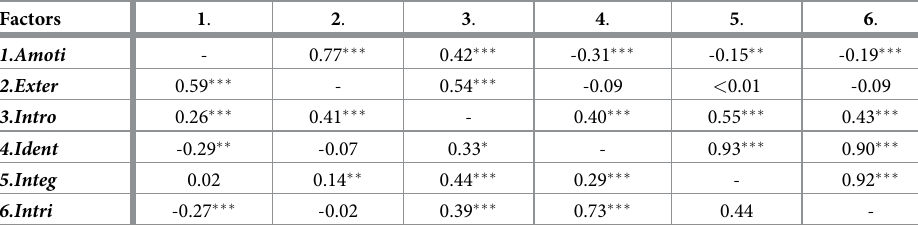
Table notes Amoti = amotivation; Exter = external regulation; Intro = introjected regulation; Ident = identified regulation; Integ = integrated regulation; Intri = intrinsic motivation; � = p < .05; �� = p < .01; ��� = p < .001. Upper diagonal shows the factor correlations in the confirmatory factor analysis model. Lower diagonal shows the factor correlations in the exploratory structural equation model.